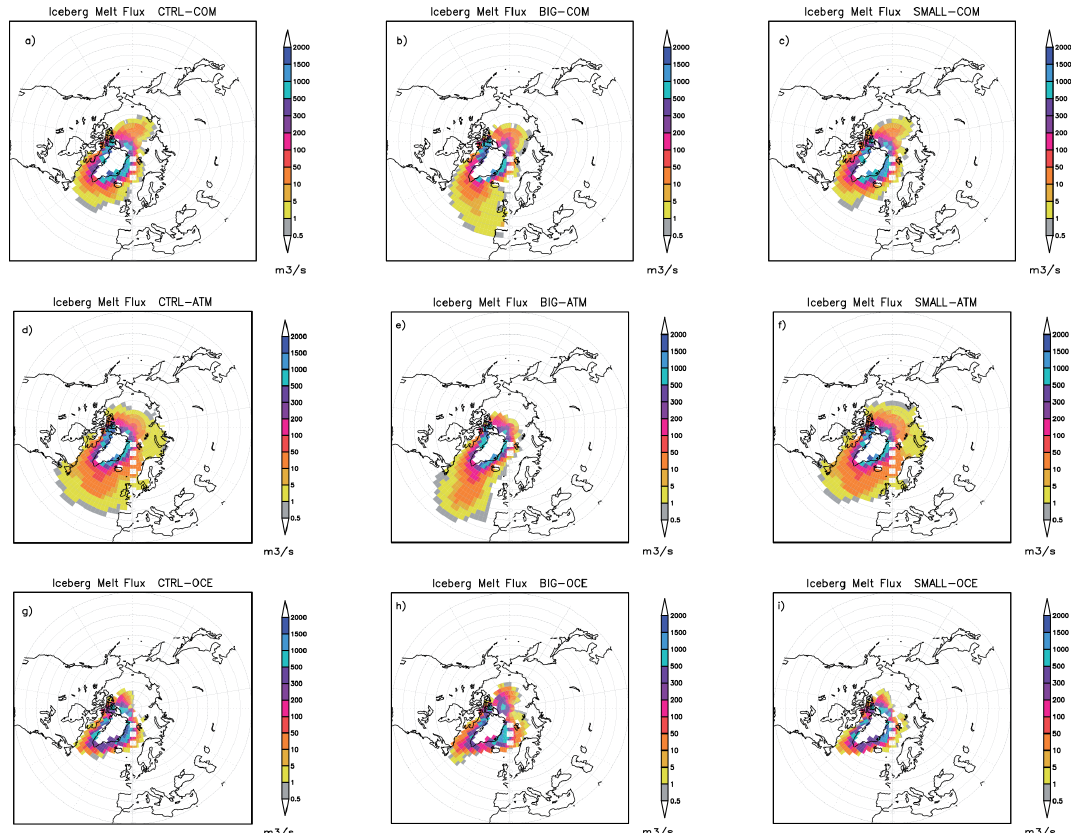
Figure 1. Iceberg melt flux (m 3 s − 1 ); first row: the default set-up (icebergs are moved by both, atmospheric and oceanic forcing; CTRTL-, BIG-, SMALL-COM); second row: atmospheric forcing only (CTRL-, BIG-, SMALL-ATM); third row: oceanic forcing only (CTRL-, BIG-,